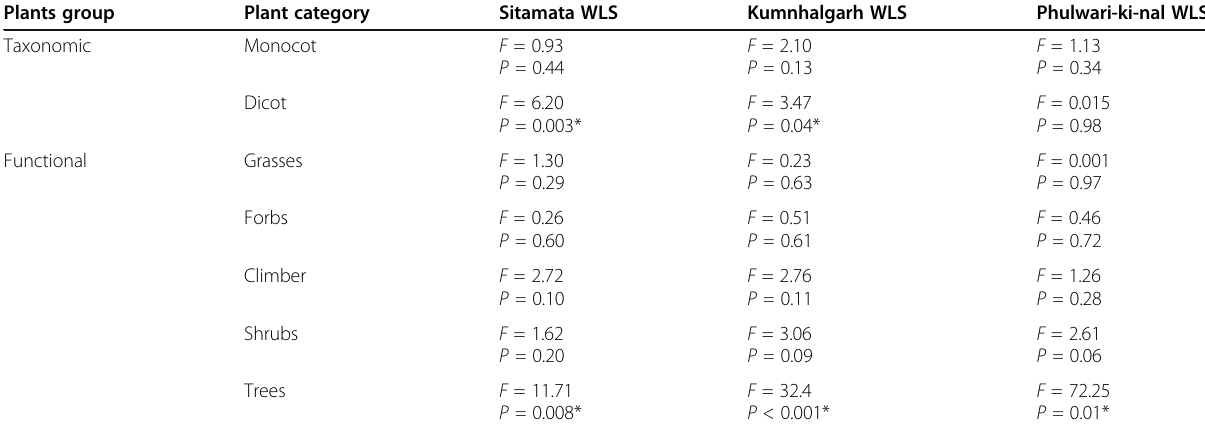
Table 3 Comparison of monocot and dicot plant consumption between seasons in each of three wildlife sanctuaries (WLS) Plants group